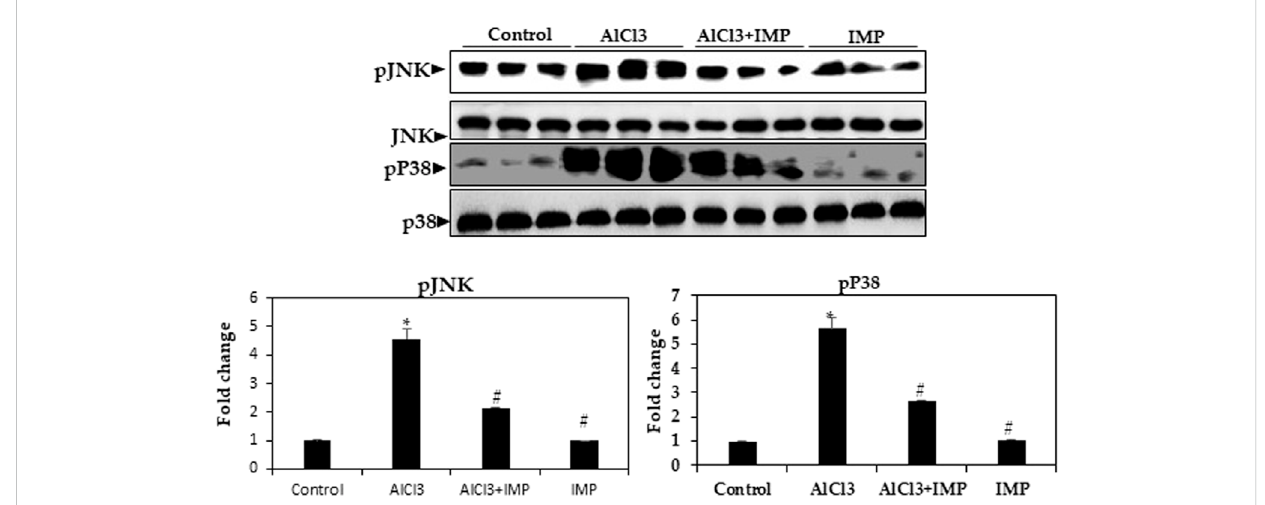
FIGURE 6 Expression of MAPK kinase in brain homogenates. Western blot analysis of brain homogenates determines the expression of pJNK and pP38 — total JNK and total p38 as a loading control. The difference between the treatment and control groups was statistically signi fi cant; * p < 0.05, # p < 0.05 was considered statistically signi fi cant. Values are expressed as mean ± SD, n = 3. * p < 0.05 means that there are signi fi cant differences between the AlCl3- alone group and the control group. # p < 0.05 shows signi fi cant differences between AlCl3 alone and IMP with AlCl3.